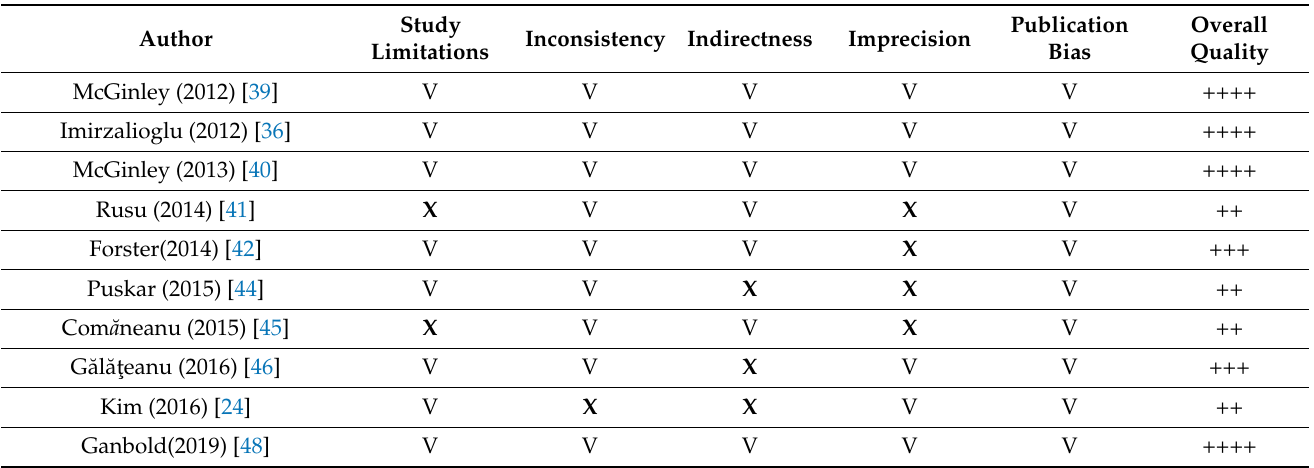
Table 3. GRADE assessment for in vitro studies. Overall quality: ++++ high, +++ moderate, ++ low, + very